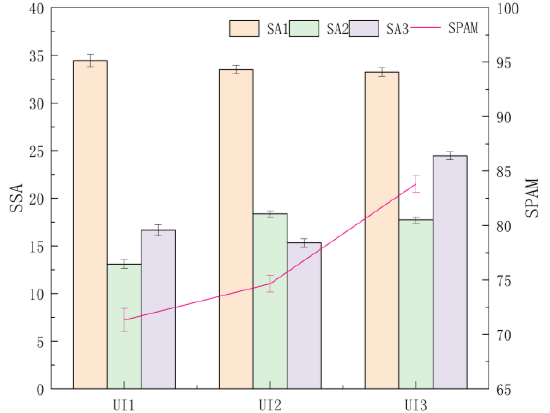
Figure 5. The stage and total scores of SA obtained by SPAM for each UI level. Note. SSA: the stage score of SA; SPAM: total score of SA; SA1: perception stage; SA2: comprehension stage; SA3: pro- jection stage; Error bar: standard